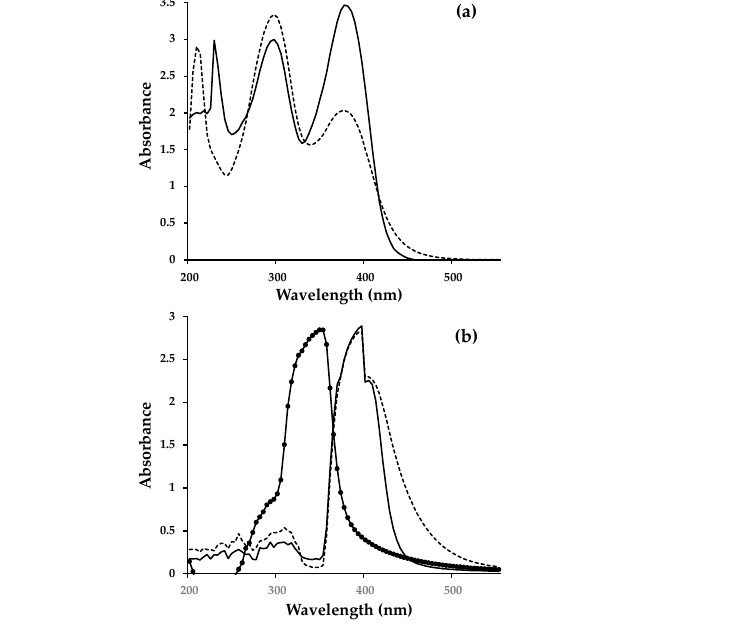
Figure 1. UV-visible spectra for ( a ) dyes dissolved in methanol and ( b ) dyes adsorbed onto a transparent, mesoporous TiO 2 film. Key: Transparent TiO 2 film—full line with circles; ( 8 )—dashed line; ( 10 )—full line.